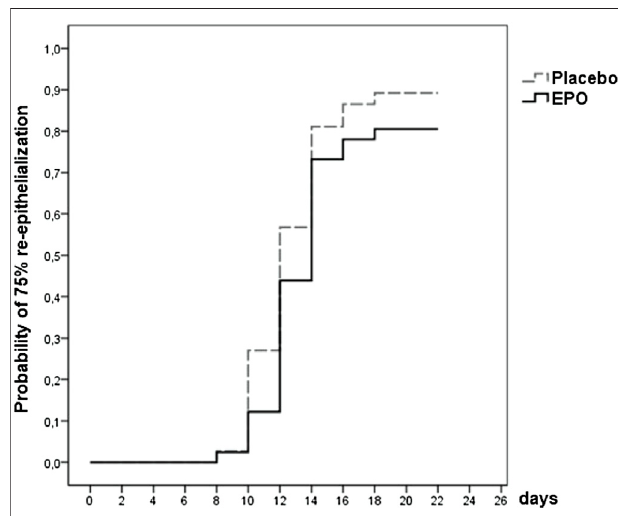
FIGURE 2 | Survival function showing the likelihood of 75% re- epithelialization through day 21 for patients from both treatment arms whose study wound healing process was fully documented [data were censored for 12 (15%)